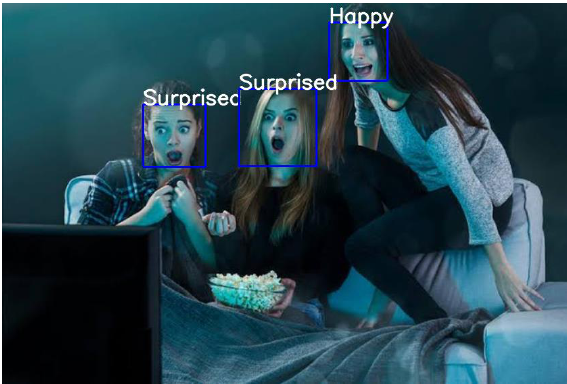
Fig. 7. Faces and emotions classified by CNN model.